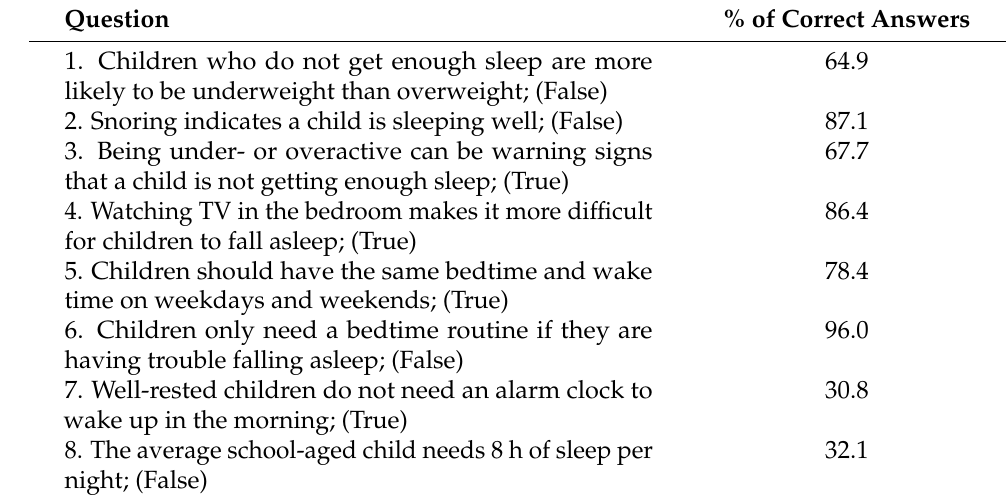
Table 6. Percentage of Parents Answering Sleep Knowledge Questions Correctly.